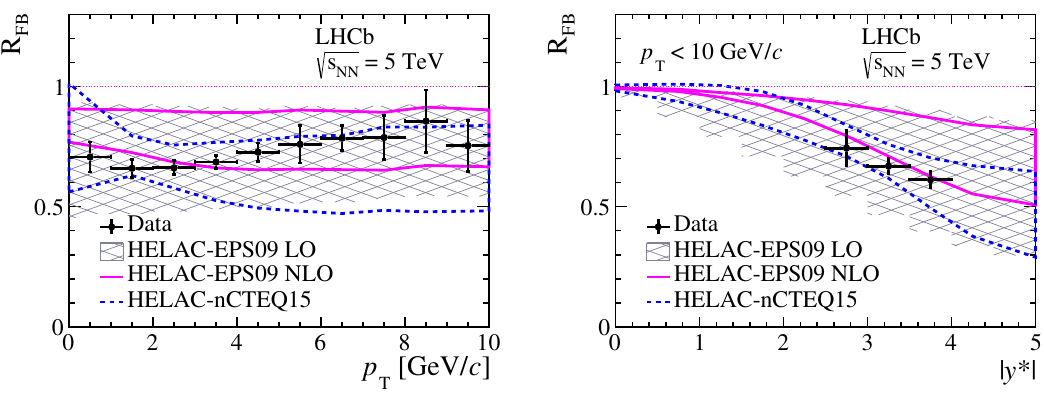
Figure 8 . Forward-backward ratio R FB for prompt D 0 meson production (left) as a function of p T integrated over the common rapidity range 2 : 5 < j y (cid:3) j < 4 : 0 for p T < 6 GeV =c and over 2 : 5 < j y (cid:3) j < 3 : 5 for 6 < p T < 10 GeV =c ; (right) as a function of y (cid:3) integrated up to p T = 10 GeV =c . The uncertainty is the quadratic sum of the statistical and systematic components.